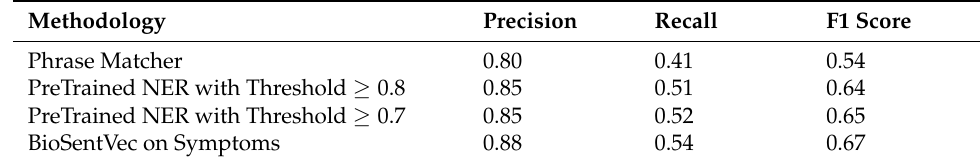
Figure 14. Chart showing the percentage of diseases and symptoms from the database that is interlinked with the standardized ontologies using different adopted methodologies. Table 3. Precision, Recall and F1 Score values for different